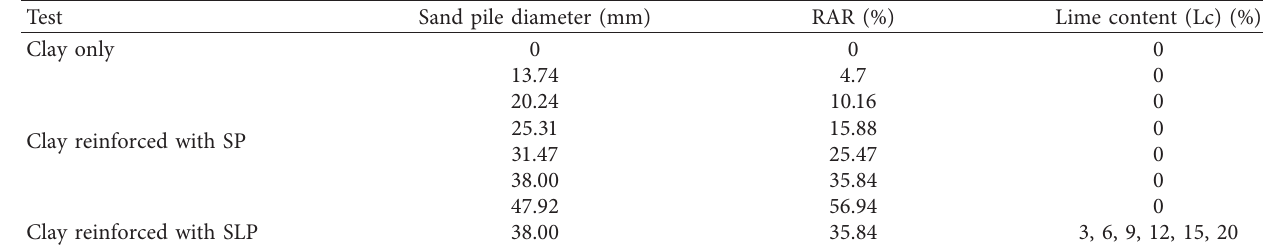
Table 1: Laboratory study program.